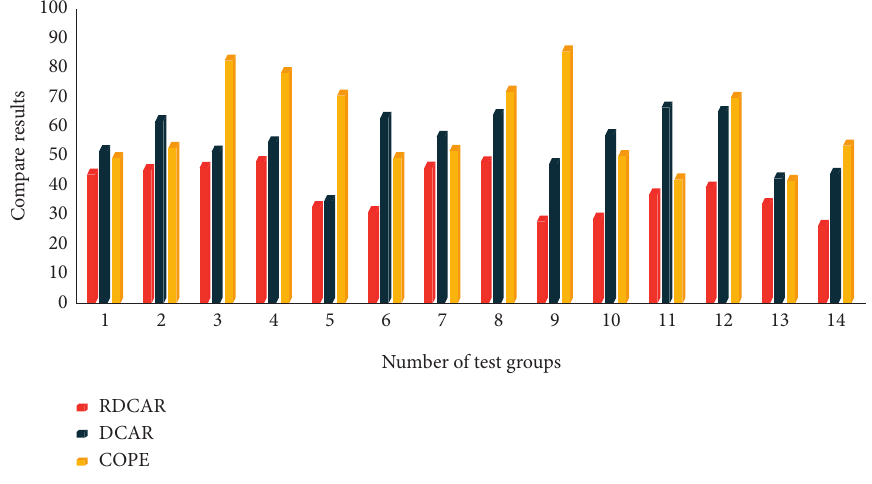
Figure 9: Comparison of encoding opportunities at different rates.